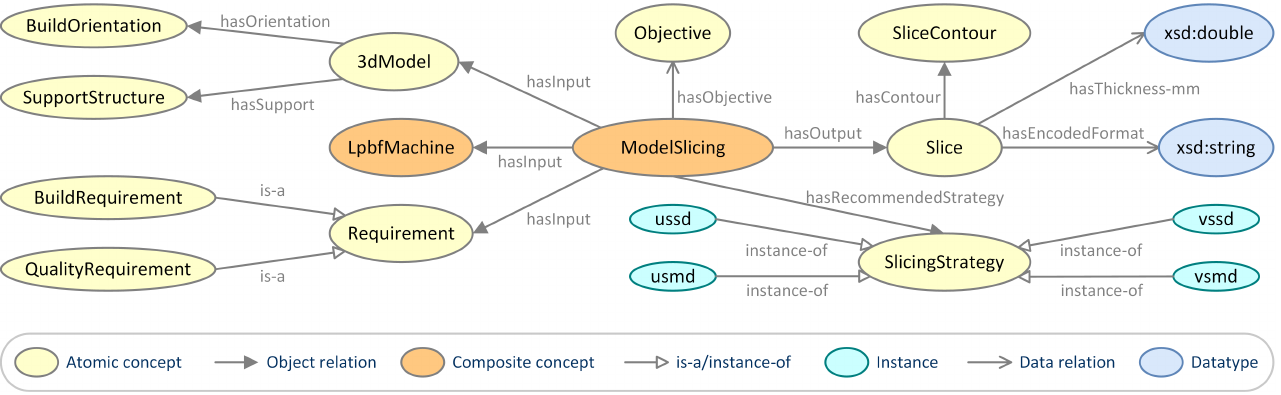
Figure 6. An ontological view of model slicing for